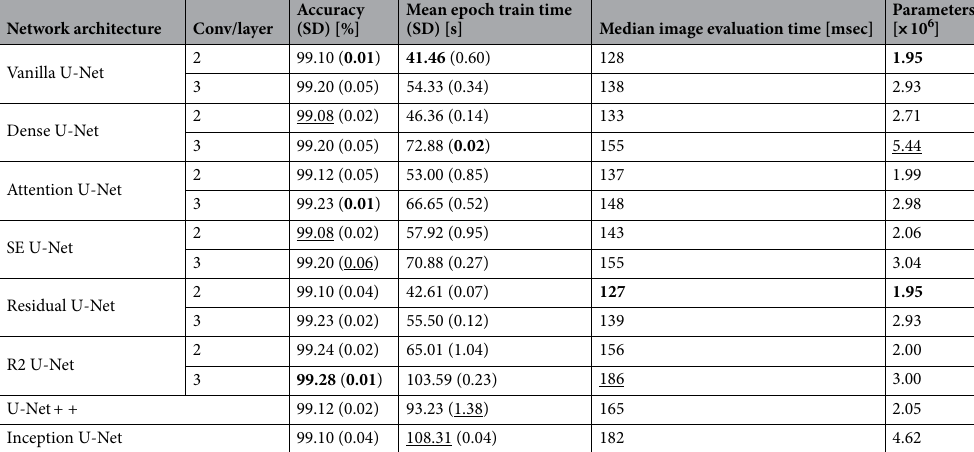
Table 2. Comparison of results for the healthy dataset. (SD: standard deviation, s: seconds, SE: squeeze + excite, R2: recurrent-residual). The best and poorest results for each are annotated in bold and underline text respectively.